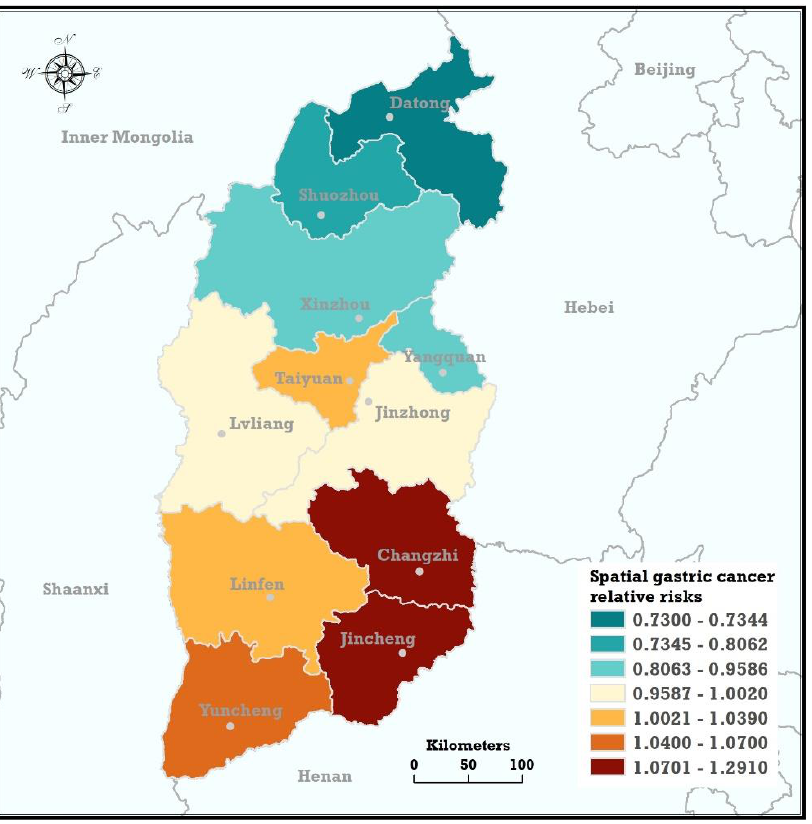
Figure 3. The spatial trends of GC relative risks based on the posterior medians of exp(𝑆 𝑖 ) , estimated by the Bayesian spatial model integrated with the selection probability model.